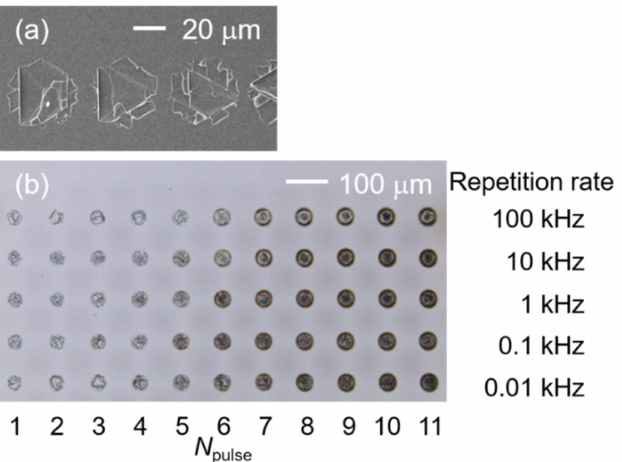
Figure 2. ( a ) SEM image of the one-pulse irradiated ZnO substrate surface under pulse energy of 60 µ J by scanning a laser beam in a line. ( b ) CLSM images of spots irradiated by laser pulses with different pulse numbers ( N pulse ) and repetition